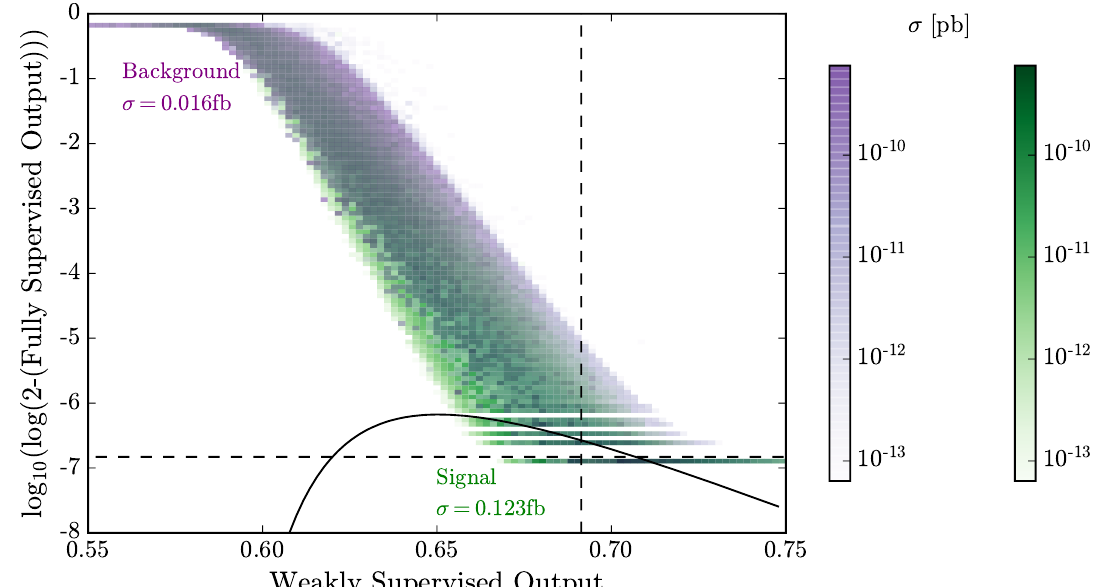
Figure 11 . Two-dimensional histogram of the weighted Z +jets background and gluino pair pro- duction signal events. The horizontal axis corresponds to the output of the weakly supervised network, with the background peaked towards values of 0.6 and signal peaked towards 0.7. The vertical axis is the output for each event from the fully supervised network, transformed to sepa- rate the values close to 1. The larger, negative values correspond to signal, while close to 0 is the background. The two dashed lines show the values of the cuts places on either individual network. The solid line represents the cut found by training a fully supervised network which uses only these two axes as input. This cut reduces the background (for the same signal cross section) by 15 : 8 % from the best cut on either network